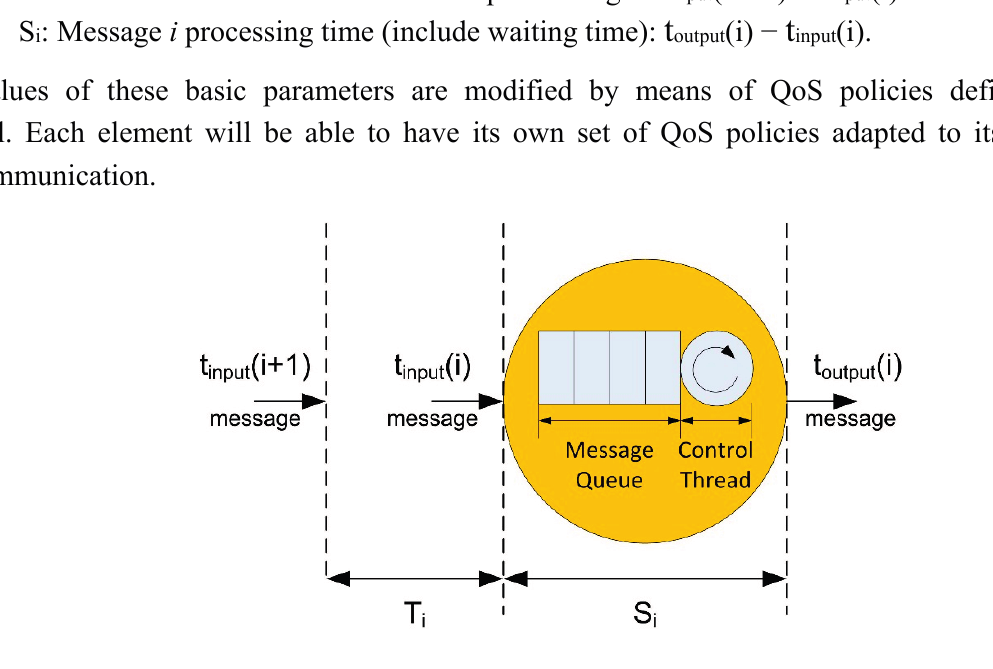
Figure 7. Internal parameters of a basic